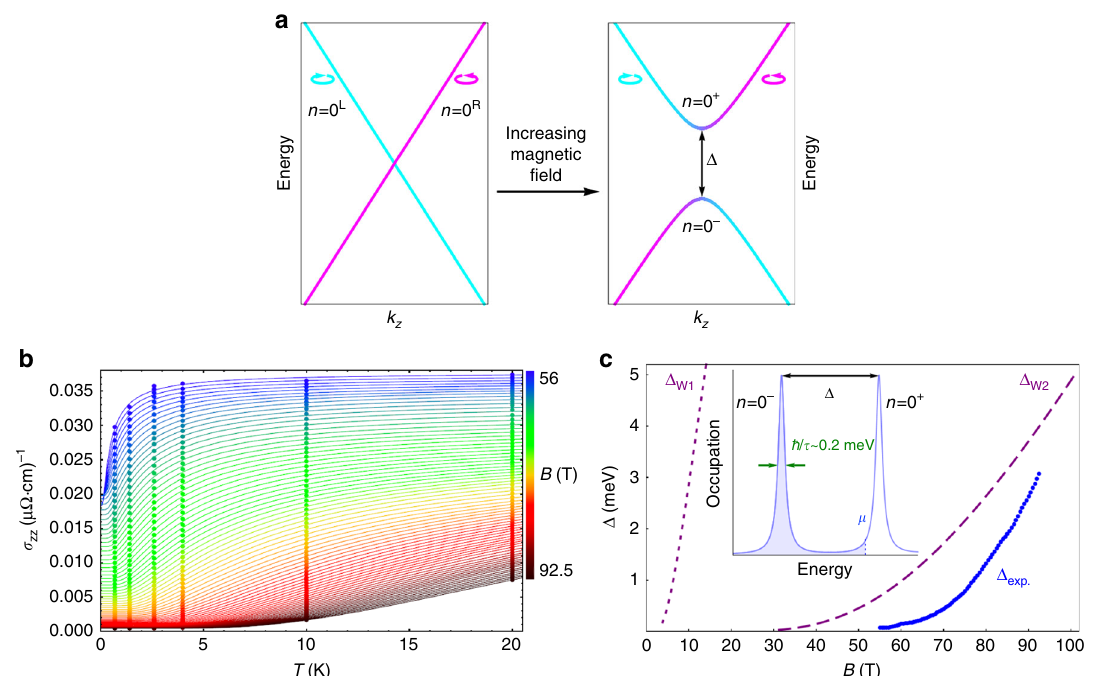
Fig. 3 Mixing of left and right-handed Landau levels in a magnetic fi eld. The left and right-handed Weyl nodes are separated in the k x – k y plane in TaAs (Fig. 1a) but are degenerate along k z . At low magnetic fi elds the left and right-handed n = 0 LLs can be considered independent ( a ). As the magnetic fi eld is increased, and the magnetic length approaches the inverse momentum-space separation of the nodes, the two LLs hybridize and a gap Δ opens that increases with fi eld. We extract this gap by fi tting the conductivity to σ zz ¼ σ 0 þ σ 1 e (cid:2) Δ kBT from 56 to 92.5 T ( b , points are data and solid lines are fi ts at different values of the magnetic fi eld), with Δ show in panel c . We fi nd that the W1 nodes gap at low fi eld due to their close momentum-space proximity 7,23,25,27 , whereas the much larger separation of the W2 nodes means that their gap opens at higher fi eld ( b ). The ≈ 0.5 meV offset between our calculated and measured gaps may be due to the ≈ 0.2 meV LL broading due to fi nite quasiparticle lifetime